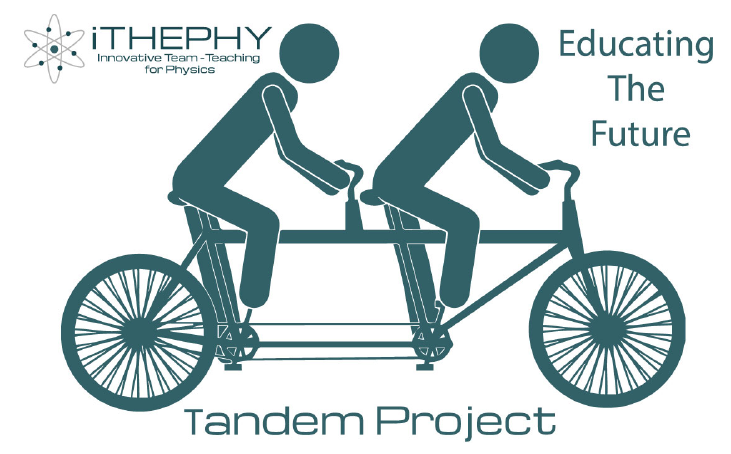
Figure 2. Tandem-Project